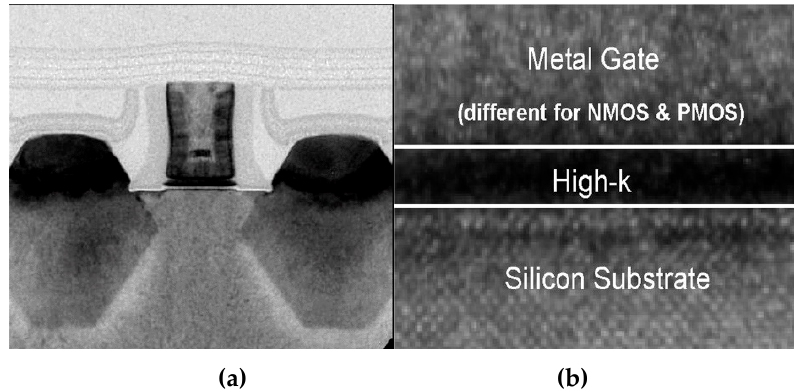
Figure 3. TEM images: ( a ) pMOS transistor and ( b ) MOS gate stack with Hf-based high-k gate dielectric [18].